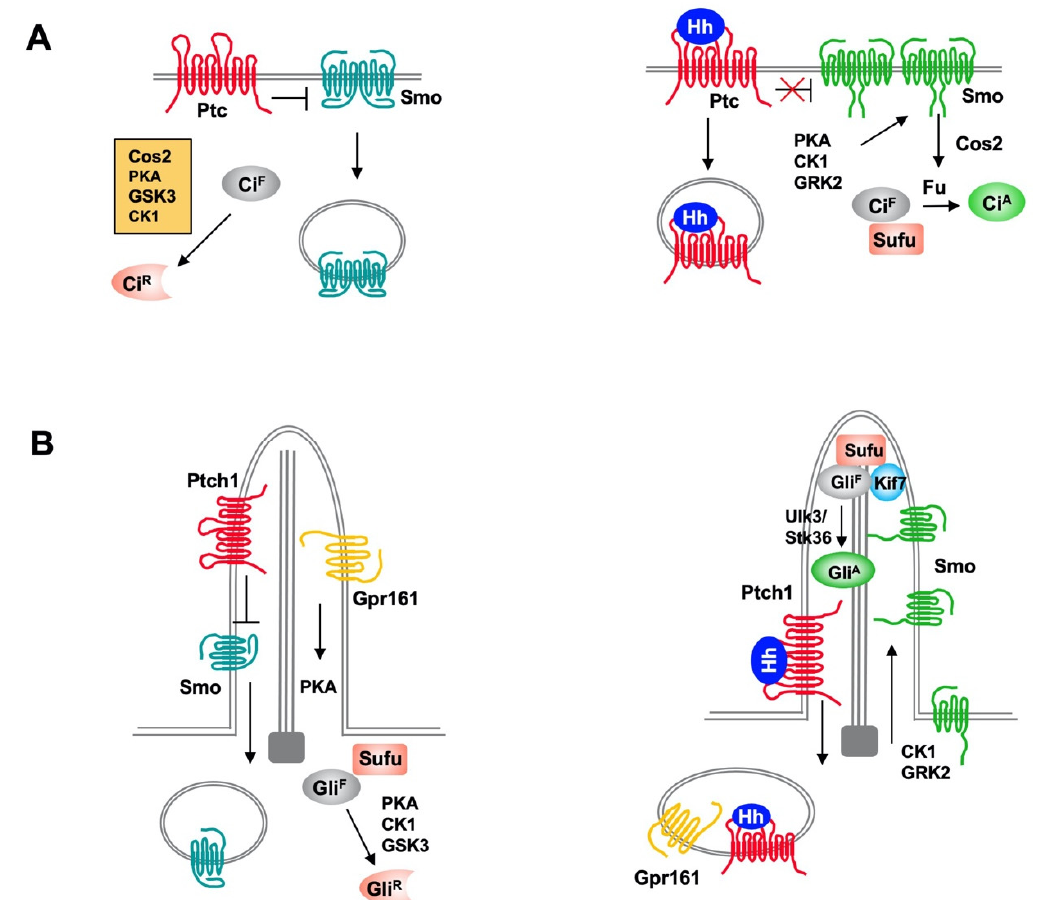
Figure 1. Hh signaling pathways in Drosophila and mammals. ( A ) In Drosophila, Ptc inhibits Smo activity and promotes its internalization and degradation in the absence of Hh. Full-length Ci (Ci F ) undergoes hyperphosphorylation by PKA, GSK3, and CK1, which is facilitated by Cos2, and phosphorylated Ci is proteolytically processed to generate a truncated repressor form (Ci R ) that inhibits Hh target gene expression. In the presence of Hh, binding of Hh inhibits Ptc activity and promotes Ptc internalization and degradation, and increases Smo cell surface accumulation and activity through PKA, CK1 and GRK2-mediated phosphorylation. Activated Smo blocks Ci R production and promotes Ci A formation by releasing Sufu-mediated inhibition of Ci through Fu. ( B ) In mammal, both the production of Gli repressor (Gli R ) and activator (Gli A ) depend on primary cilia. In the absence of Hh, ciliary localized Ptc inhibits Smo and promotes its ciliary exit and ciliary localized GPR161 activates PKA through local production of cAMP to promote Gli phosphorylation, which leads to processing of Gli F to Gli R . In the presence of Hh, Shh inhibits Ptc and induces ciliary exit of Ptc, allowing Smo to be activated and accumulated in cilia. Smo promotes ciliary exit of GPR161 to inhibits Gli R formation and promotes Gli A formation through Ulk3/Stk36-mediated phosphorylation of